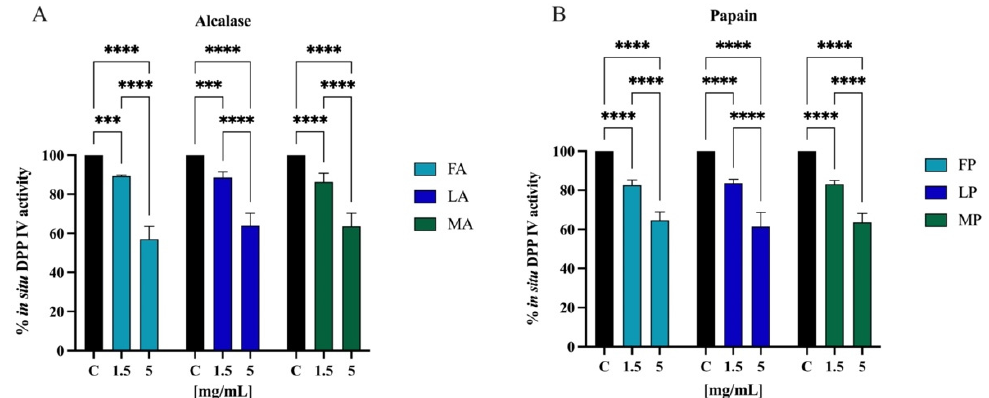
Figure 11. Effect of olive seed hydrolysates obtained from Frantoio (F), Leccino (L), and Moraiolo (M) using alcalase (A) ( A ) and papain (P) ( B ) on DPP-IV activity expressed by Caco-2 cells. The data points represent the averages ± s.d. of four independent experiments, and each experiment was performed in triplicate. All data sets were analyzed by two-way ANOVA followed by Tukey’s post hoc test. (***) p < 0.001, (****) p < 0.0001.